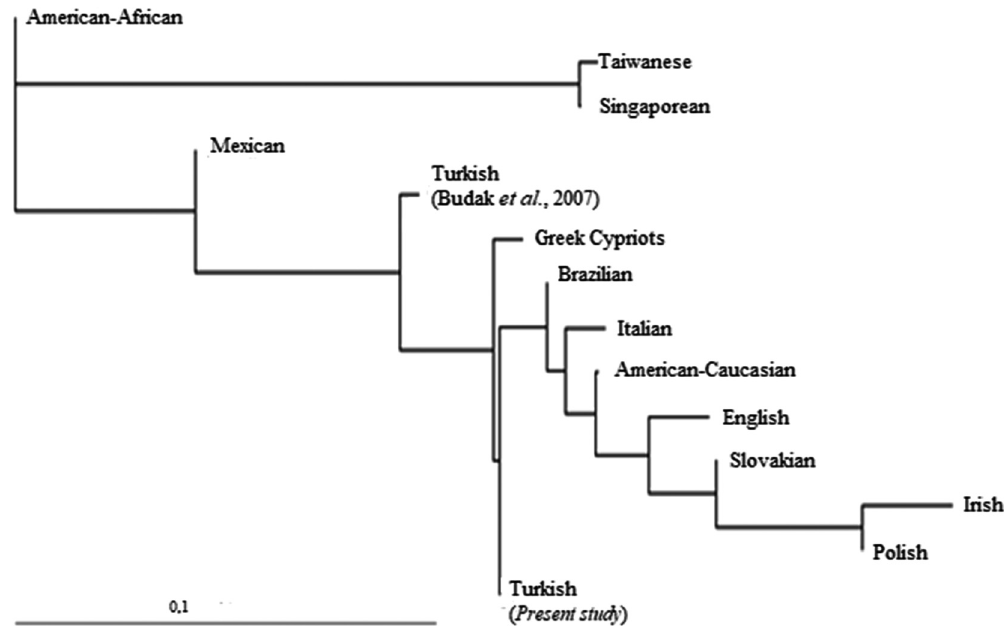
Figure 1: Phylogenetic tree of the investigated populations based on TNFA, IL6, IL10